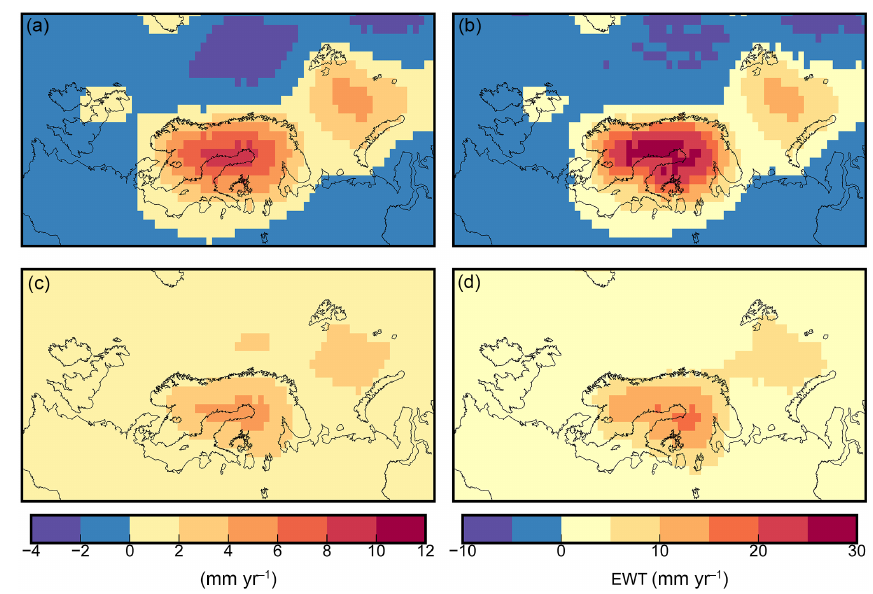
Figure 5. Averaged a priori rates of the Earth–ice model set. (a, c) Vertical rates and uncertainties. (b, d) Gravity change rates and uncertain- ties in units of equivalent water thickness (EWT)